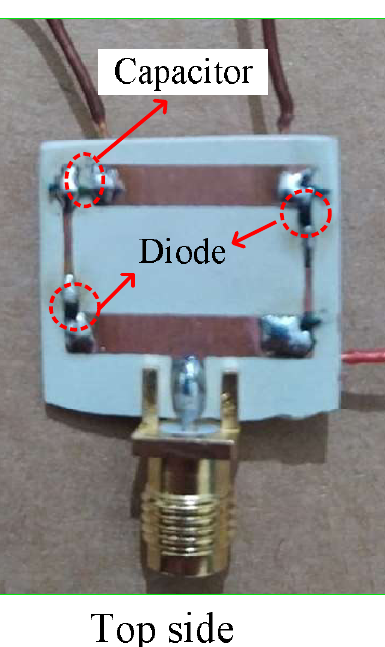
Figure 5. Fabricated prototype of the proposed antenna design.